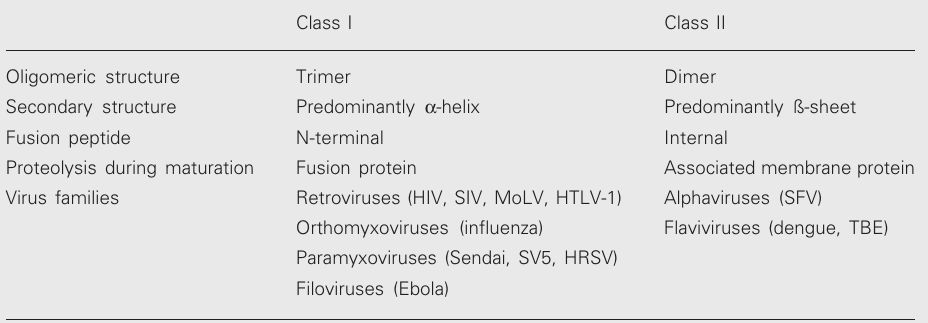
Table 1. Characteristics of viral fusion protein